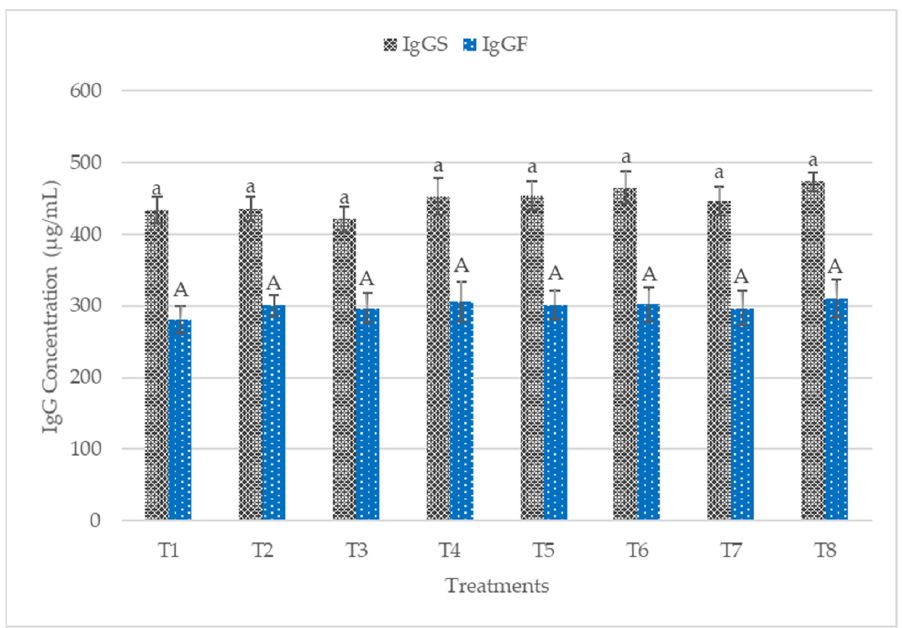
Figure 3. Plasma immunoglobulin G (IgG) concentrations of starter and finisher broiler chicken fed postbiotics and paraprobiotics. Bars with the same letters were not significantly different ( p > 0.05) for both IgG for starter and IgG for finisher, n = 6. T1 = negative control (Basal diet), T2 = positive control (Basal diet + 0.01% ( w / w ) Oxytetracycline), T3 = Basal diet + 0.2% ( v / w ) postbiotic TL1, T4 = Basal diet + 0.2% ( v / w ) postbiotic RS5, T5 = Basal diet + 0.2% ( v / w ) paraprobiotic RG11, T6 = Basal diet + 0.2% ( v / w ) postbiotic RI11, T7 = Basal diet + 0.2% ( v / w ) paraprobiotic RG14, T8 = Basal diet + 0.2% ( v / w ) paraprobiotic RI11. IgGS = Immunoglobulin M for starter, IgGF = Immunoglobulin M for